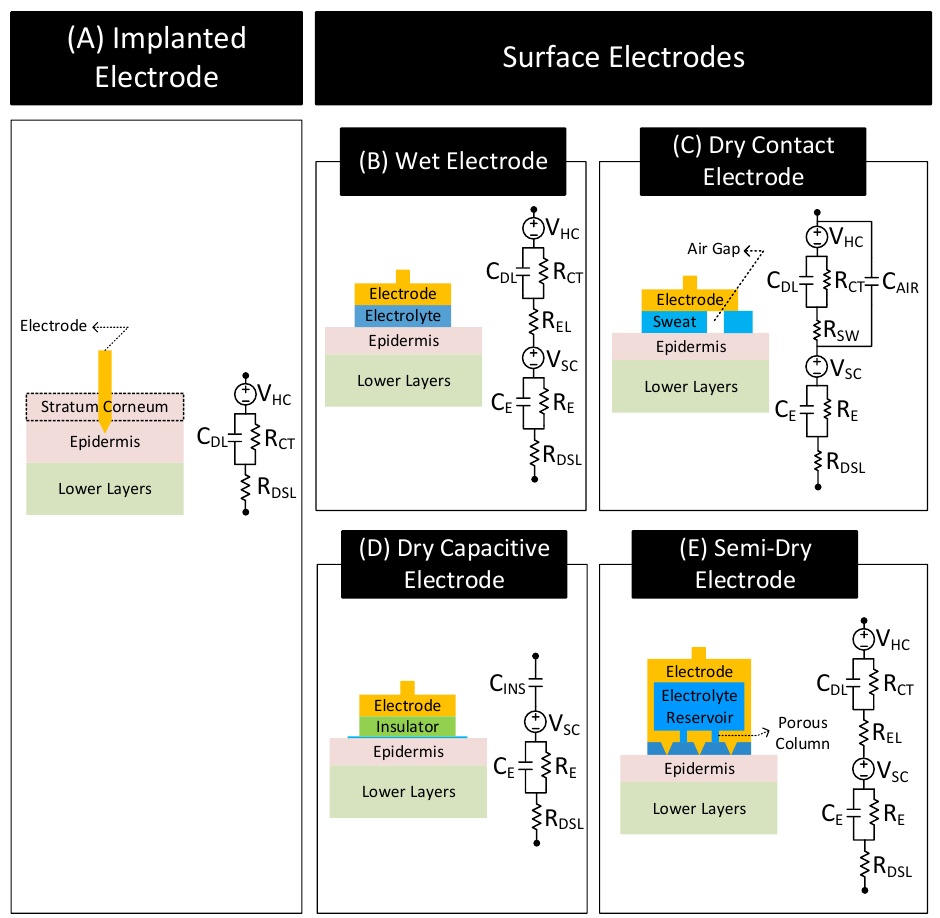
Figure 6. Layer stack and circuit model of the electrode–body interface for different electrode types. Inspired from